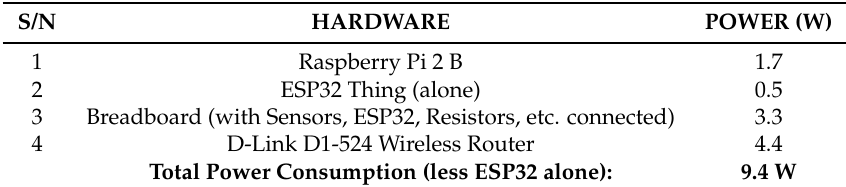
Table 2. Power consumption of hardware